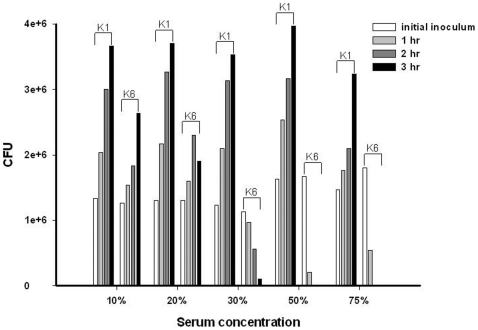
The effect of serum dilution on the serum killing of K. pneumoniae serotypes K1 and K6.A high concentration of serum inhibited the growth of K6 but not K1. Each experiment was repeated in triplicate. The bacteria counts are expressed by cell forming unit (CFU).